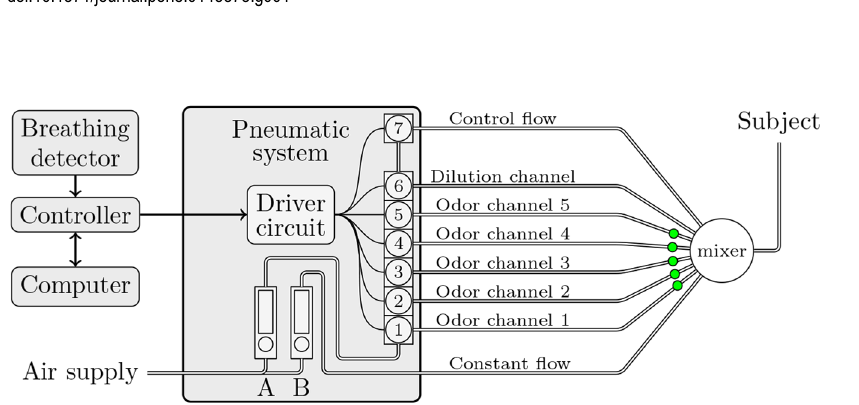
Fig 2. Schematic view of olfactometer. This “ Lorig design ” was modified by adding a dilution channel enabling its use with